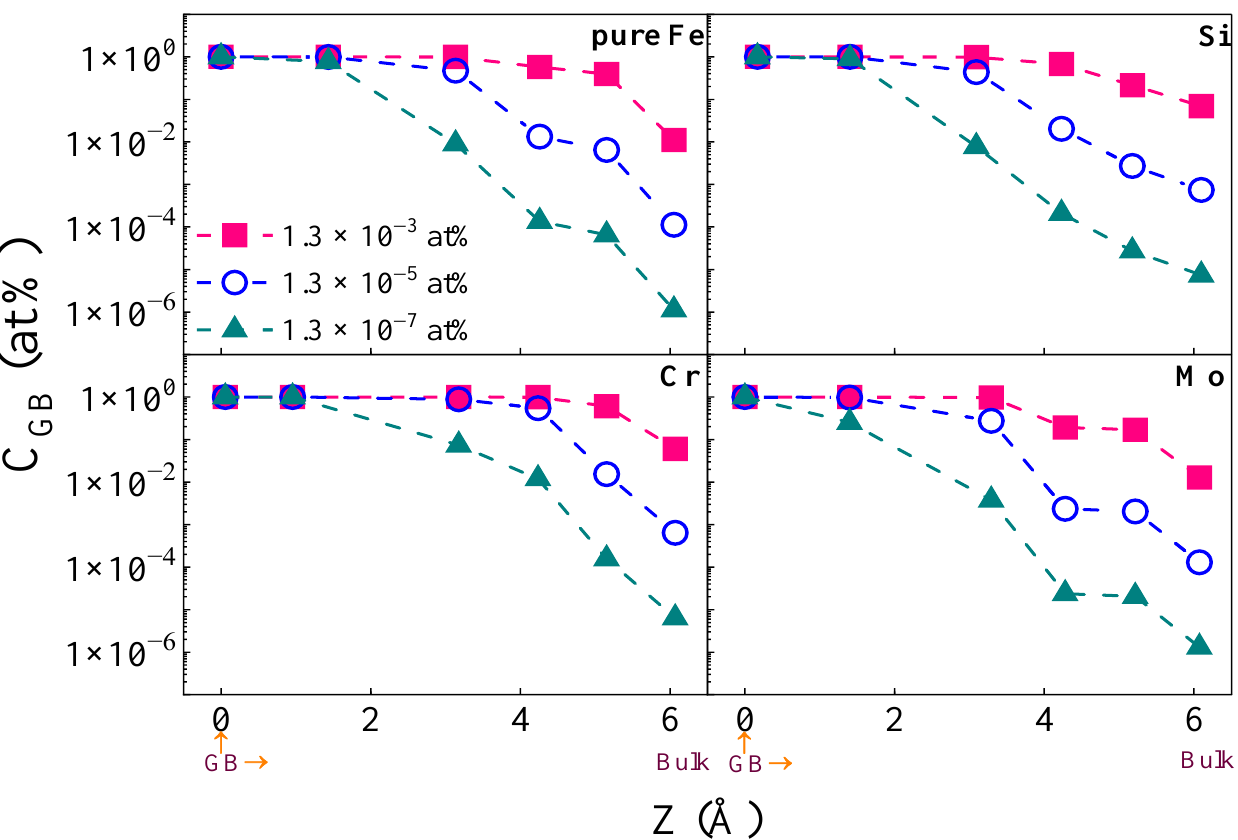
Figure 8. The concentration of O as a function of the distance from the GB plane. The pink solid square, blue open circle and cyan solid triangle represent the concentrations of O atoms at different positions relative to the GB plane when the O concentration in the bulk ( C Bulk ) is 1.3 × 10 − 3 , 1.3 × 10 − 5 and 1.3 × 10 −7 at%, respectively.